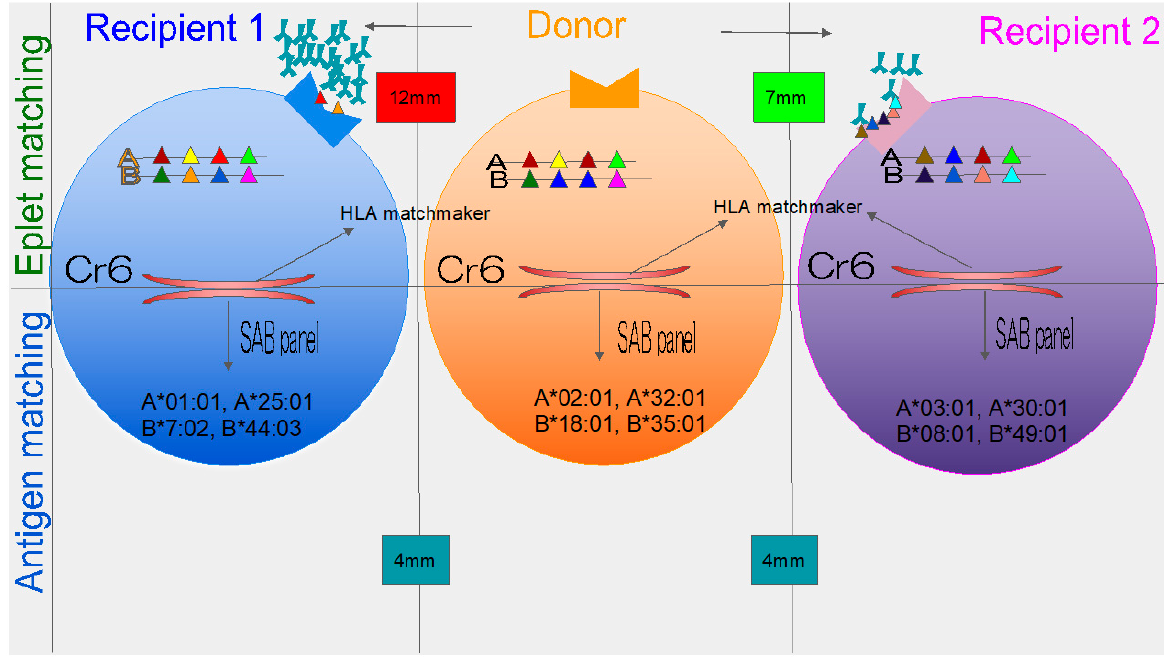
Figure 1. Schematic comparison between antigen and eplet matching approaches. The HLA typing for donors and two potential recipients reveals an equal number of mismatches (mm) at A and B loci. However, eplet matching views antigens (A, B) as a sequence of polymorphic amino acids which adopt a tridimensional conformation in the HLA protein. By considering the quaternary structure, the eplet approach offers far greater discrimination power and matching capacity. Thus, even though the two potential recipients have an equal number of antigen-level mm, recipient 2 is a better match at the eplet level. This could translate into less donor-specific antibody development and better long-term graft survival.